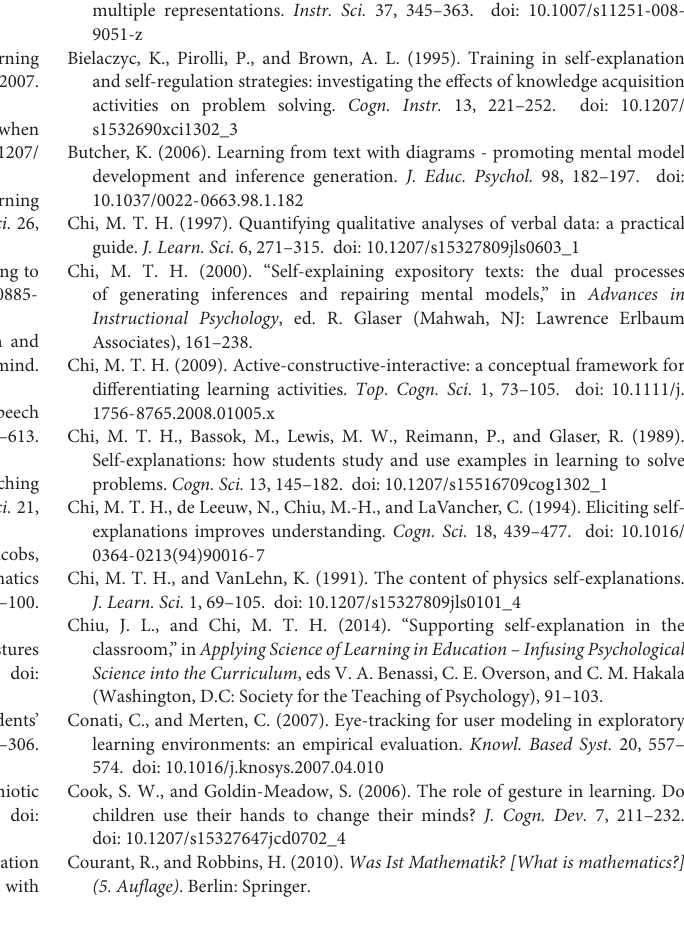
Supplementary Data Sheet 1 | List of self-explanations. Supplementary Data Sheet 2 | Worked-out